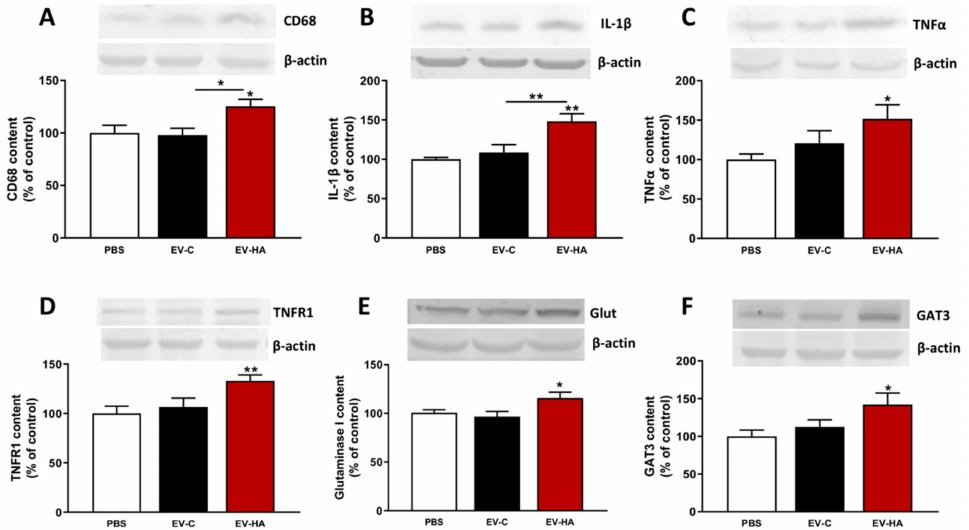
Figure 7. Total content of proteins linked with neuroinflammation in cerebellum of injected rats analyzed by Western blot. Content of ( A ) CD68 ( n = 9–11), ( B ) IL-1 β ( n = 5–7), ( C ) TNF α ( n = 9), ( D ) TNFR1 ( n = 6–11), ( E ) Glutaminase 1 ( n = 10–13), and ( F ) GAT-3 ( n = 10–12) in cerebellum homogenates. Representative images of the blots of each protein and the load control ( β -actin) are shown. One-way ANOVA with Tukey post-hoc test was performed to compare all groups. Values are expressed as percentage of protein content in PBS-injected rats and are the mean ± SEM. Values significantly di ff erent from PBS or EV-C group are indicated by asterisk (* p < 0.05, ** p <